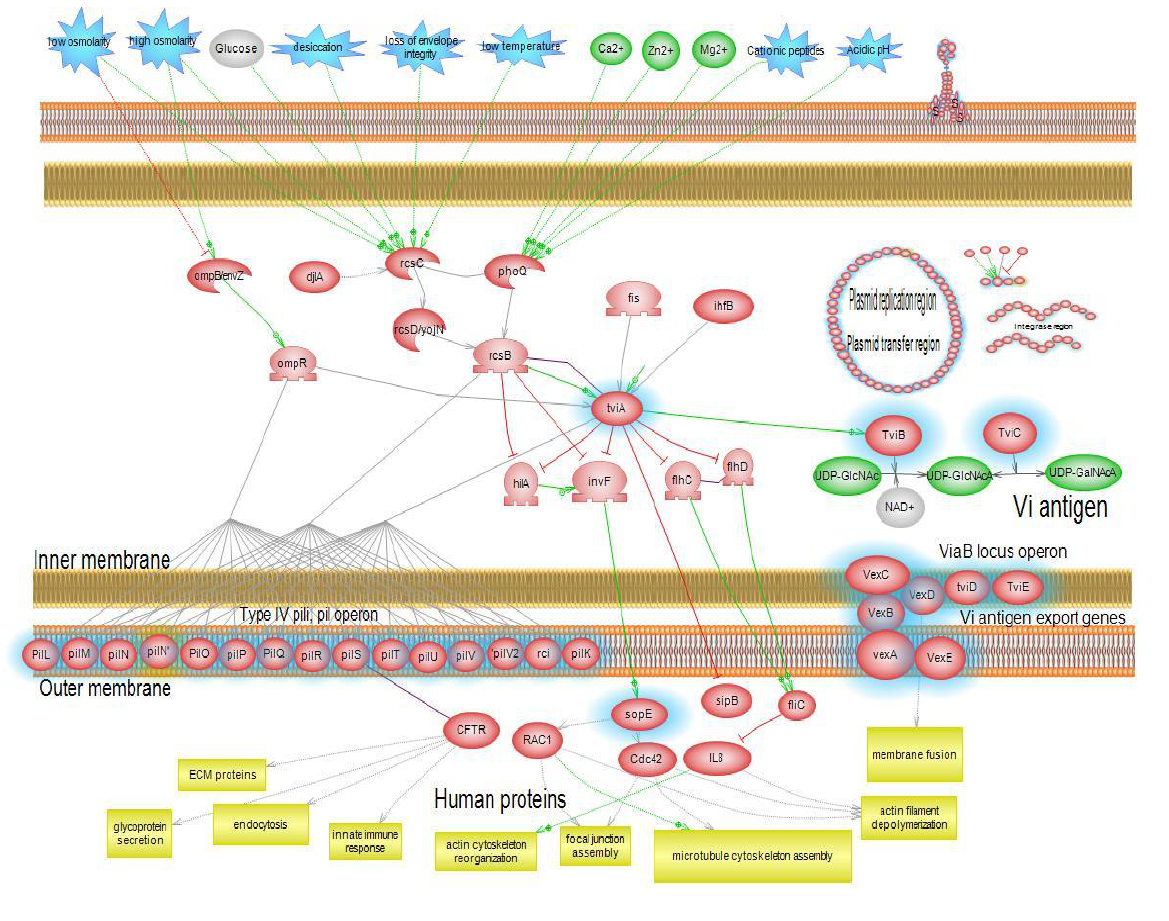
Figure 8: SPI-7 regulation pathway. SPI-7 carries genes for potential virulence factors such as Vi antigen, SopE, and type IV pili. Proteins encoded by SPI-7 are highlighted in blue. A detailed view of the SPI-7 pathway including supporting literature is available at A detailed view of the SPI-5